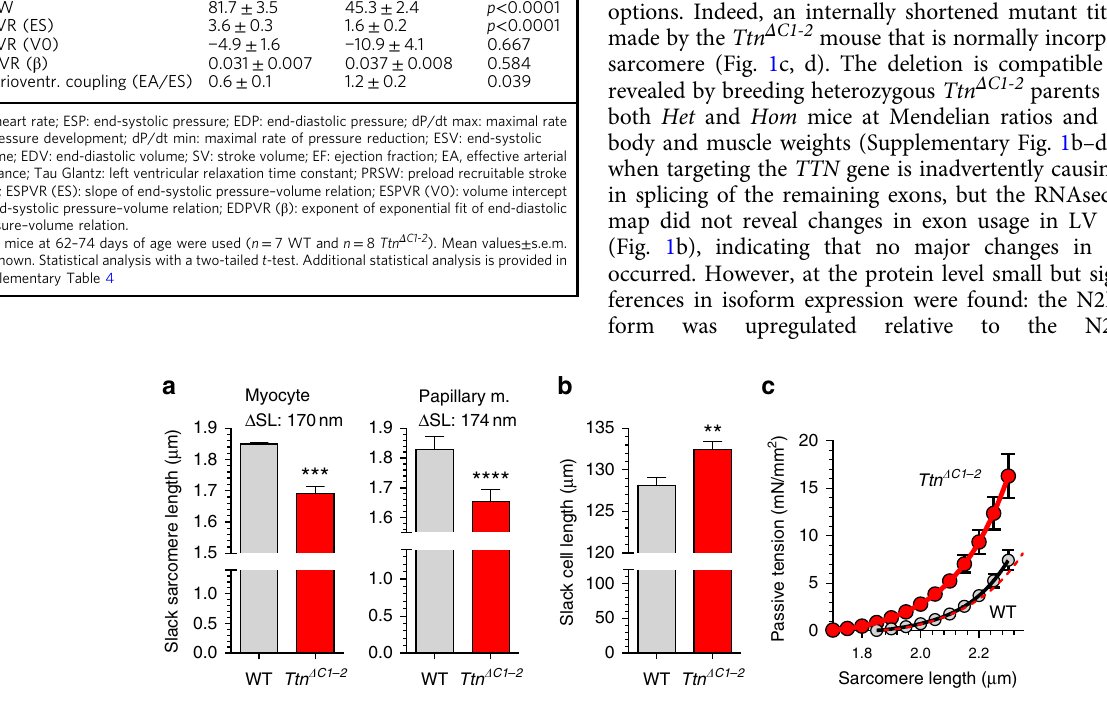
Fig. 4 Effect of reduced thick fi lament length on slack sarcomere length ( a ), slack cell length ( b ), and passive tension ( c ). Skinned myocytes ( a , left) and skinned papillary muscle ( a , right) isolated from the left ventricle have shorter slack sarcomere length in Ttn Δ C1-2 mice, but cell length is longer ( b ). c Passive tension of skinned cardiac myocytes as a function of sarcomere length increases steeper in Ttn Δ C1-2 mice. Individual data points were fi t with a fourth-order polynomial function. Dashed red line represents the fi t of the Ttn Δ C1-2 data right-shifted by 173 nm. Note that the right-shifted Ttn Δ C1-2 fi t overlaps well with WT data. a , left: mean results from 5 hearts (20 cells per heart); a , right: mean results from 12 muscles from 12 mice; c mean results from 5 myocytes from 3 hearts. Female mice at 48 – 56 days of age were used ( n = 6 WT and n = 6 Ttn Δ C1-2 ). Error bars are s.e.m. Statistical analysis with a two-tailed t -test. Additional statistical analysis is provided in Supplementary Table 4 (** denotes p < 0.01, *** p < 0.001, and **** p <